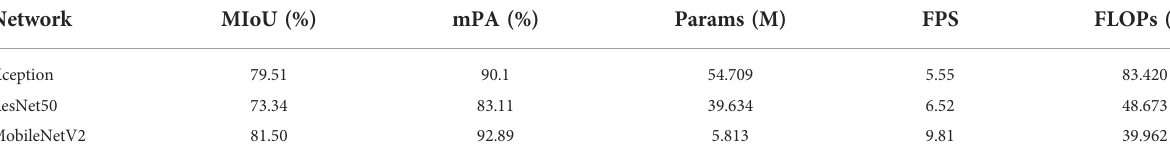
TABLE 5 Compare the segmentation performance of different feature extraction networks.